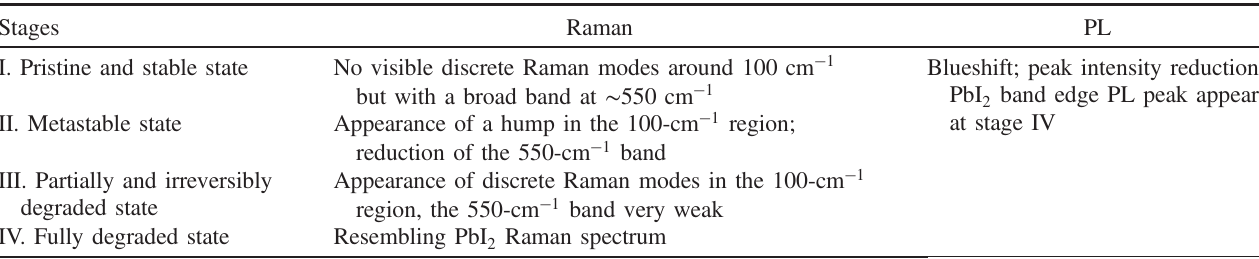
TABLE III. Key spectroscopy characteristics of the four structure transformation stages.